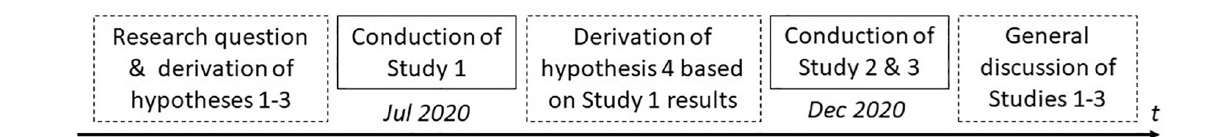
FIGURE 2 | Timeline of Studies 1–3